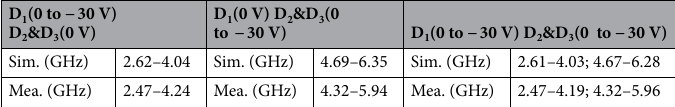
Table 2. Measured and simulated notch frequency bands comparison.